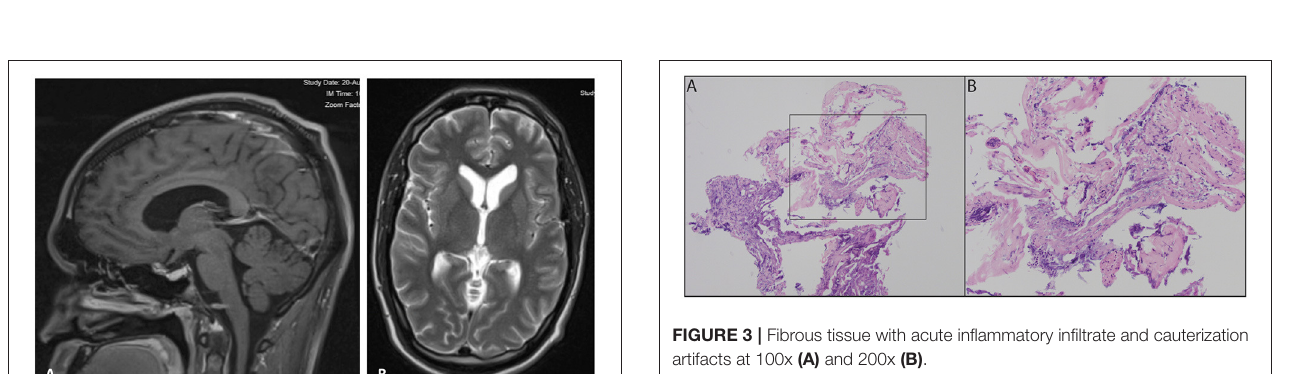
FIGURE 1 | Sagittal (A) and Axial (B) non contrast Head CT showing a hypodense lesion in the sella/suprasellar region (white arrow), with associated scattered hypodense globules along the parasagittal sulci and left sylvian fissure (red arrows) (C) Sagittal T1 fluid-attenuated inversion recovery (FLAIR), (D) 3D T2 fast spin-echo (FSE), and (E) Coronal T1-weighted MRI showing a ruptured sellar dermoid cyst with pathognomonic blood-fat-CSF level (white arrow).